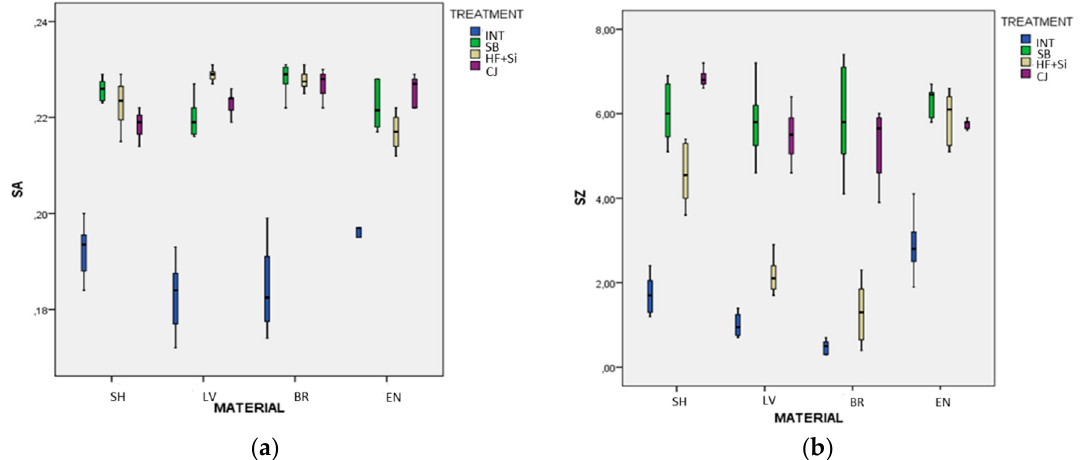
Figure 2. (a) Box plot results of the S a data, ( b) box plot results of the S z data. SH: Shofu Block HC, LV: Lava Ultimate, BR: Brilliant Crios, EN: Vita Enamic, INT: intact, SB: sandblasting, HF + Si: hydrofluoric acid and silane, CJ: Cojet system.